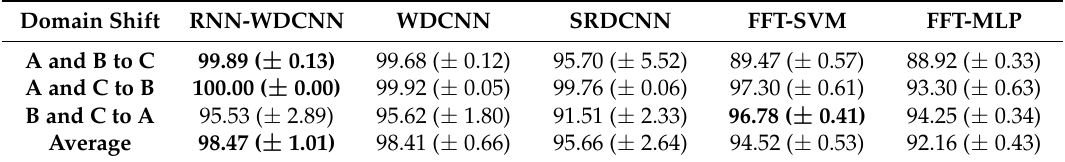
Table 11. Recall scores of the models considered in this work (as a percentage) for the domain adaptation task considered in scenario 2 (best values are highlighted in bold).